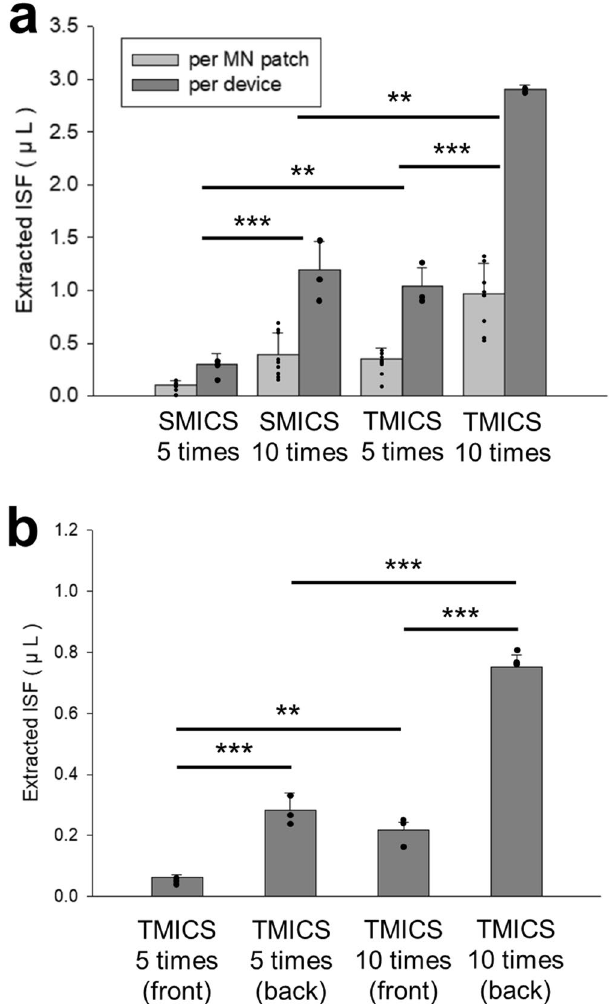
Figure 5. ISF collecting using the MN devices from the skin of Wistar rat in vivo. Skin ISF was extracted from SMICS or TMICS with five- or ten-times application. ( a ) Total extracted ISF from the front and backside of the MN patch (per each MN patch and also per each device). ( b ) Extracted ISF from the front and backside of the MN patch in TMICS with five- or ten-times application. Graphs present average ± standard deviation based on 3 replicate samples. **,***Indicate significant difference (An unpaired t-test, p < 0.005, 0.001,